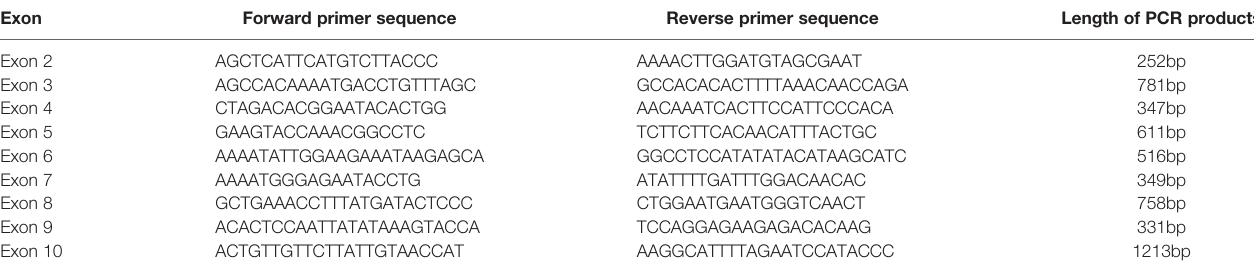
TABLE 1 | Primers used in the PCR ampli fi cation for GHR gene. Exon Forward primer sequence Reverse primer